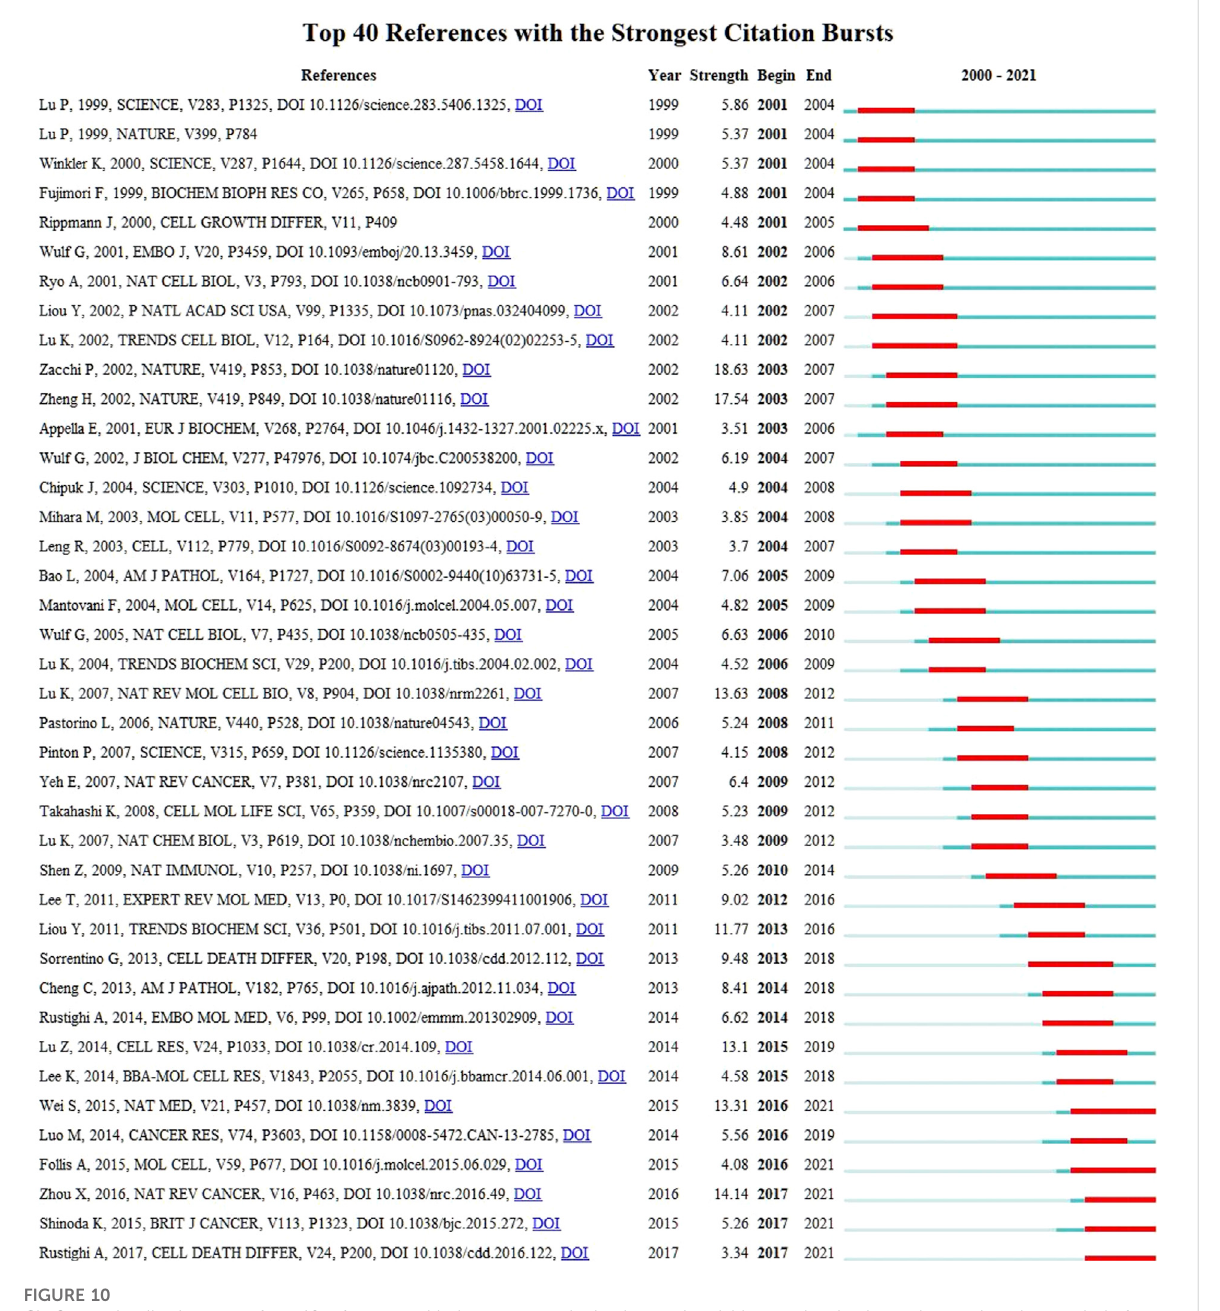
Frontiers in Cell and Developmental